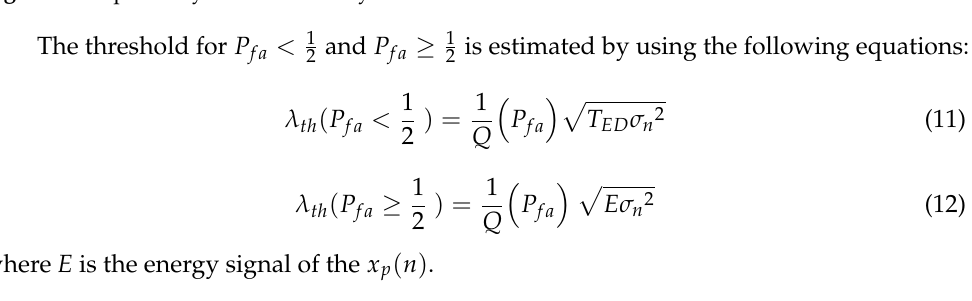
Figure 3. Proposed hybrid detection system.